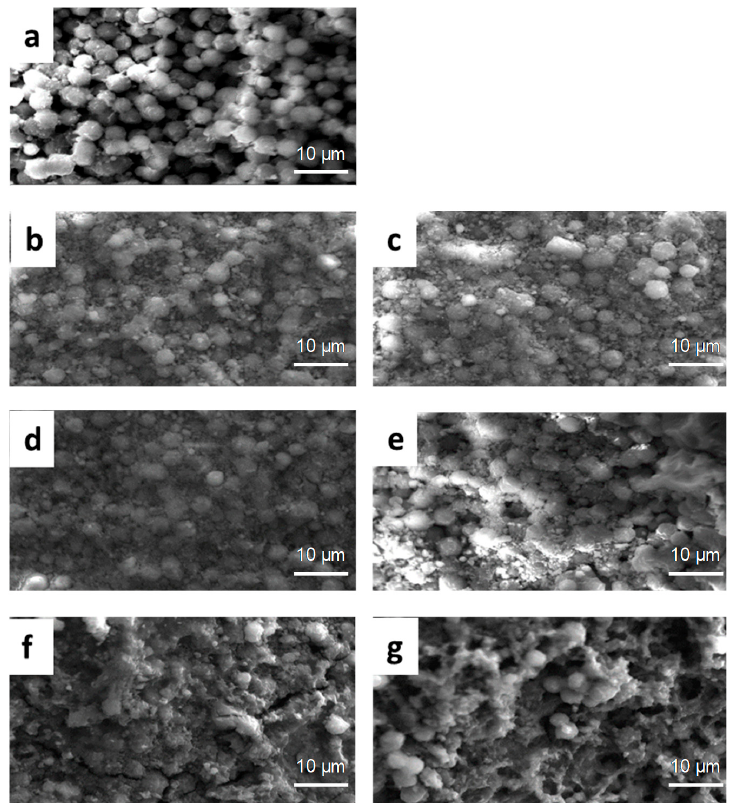
Figure 4. SEM micrograph of fresh ( a ) and spent catalysts after 1st, 2nd and 3rd pyrolysis experiments with ( b – d ) non pre-treated and ( e – g ) pre-treated